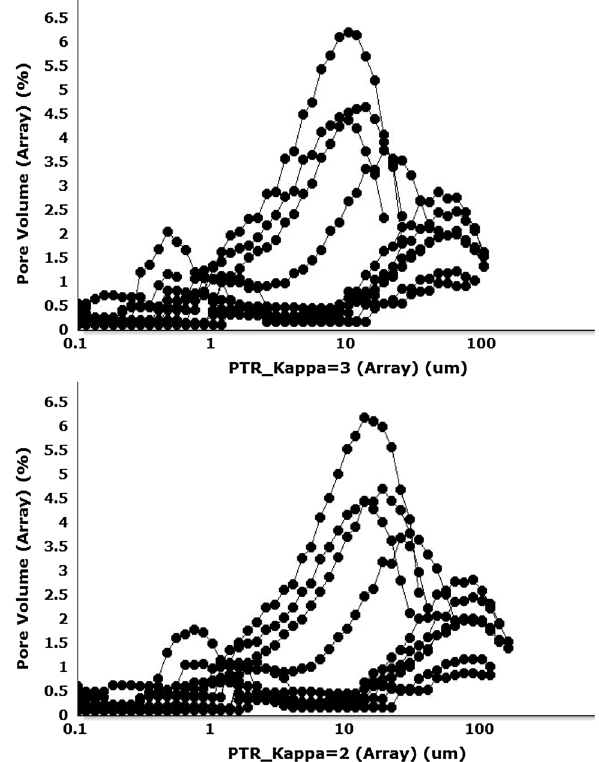
Fig. 6 Pore throat size distribution derived from NMR capillary pres- sure for kappa = 3 [after Volokitin et al. (top plot) and kappa = 2 (bot- tom